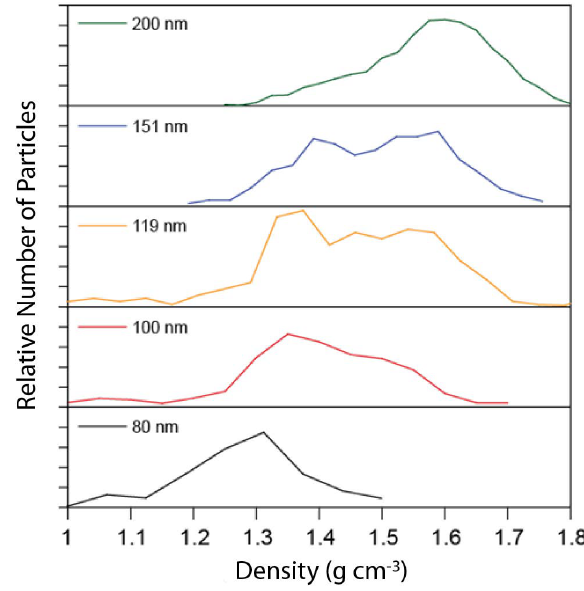
Fig. 14. Size-dependent particle densities as measured by SPLAT II on 6 June at 10:00